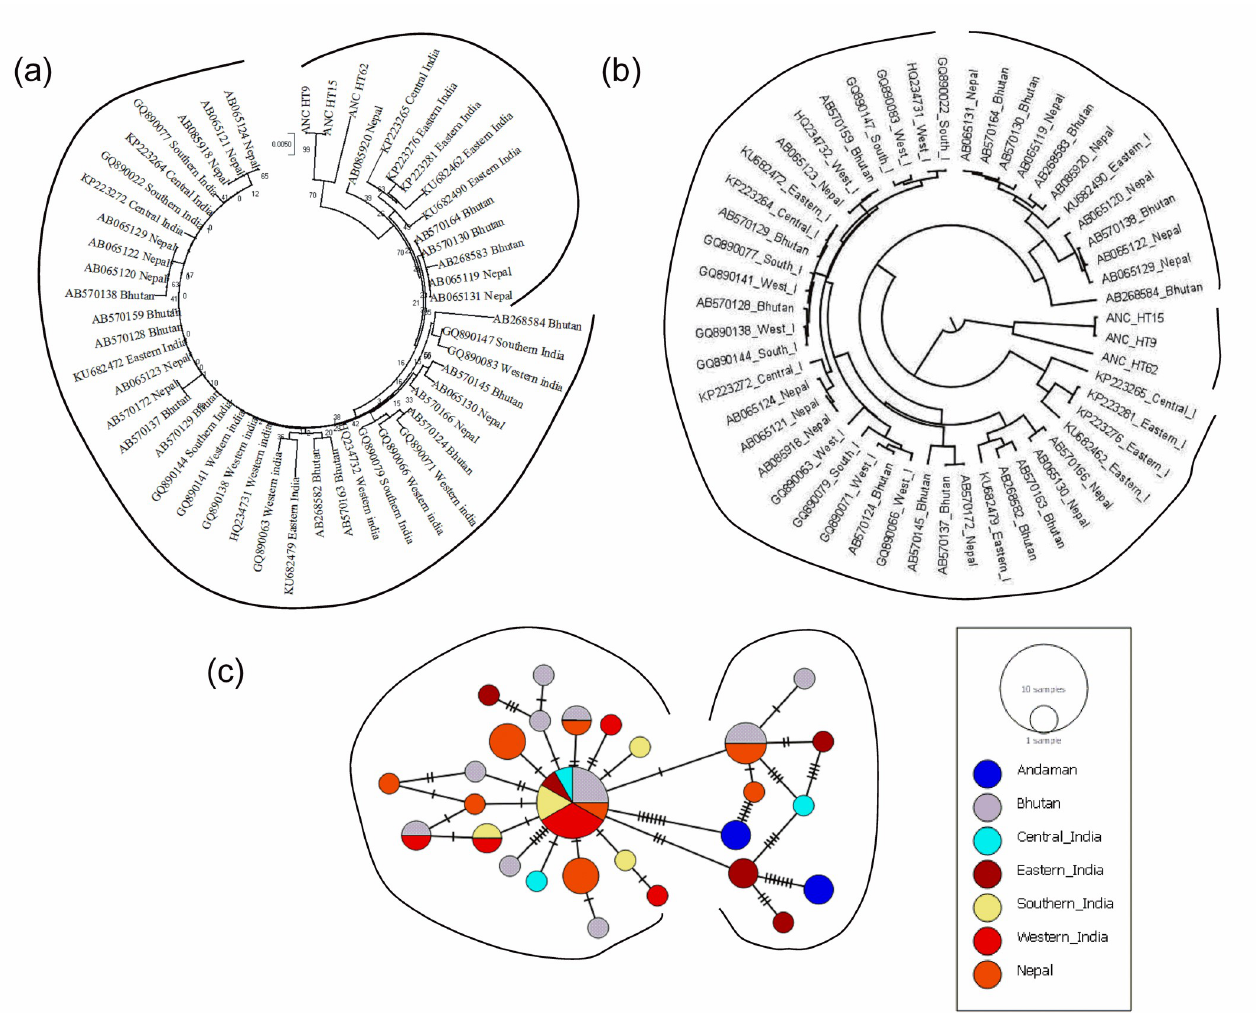
Fig 7. Haplogroup T and its relationship with T haplogroup cattle of Island Southeast Asian countries and Indian subcontinent. (a) Neighbor Joining (NJ) phylogenetic tree, (b) Bayesian phylogenetic tree, (c) A haplotype network map of the haplotypes.